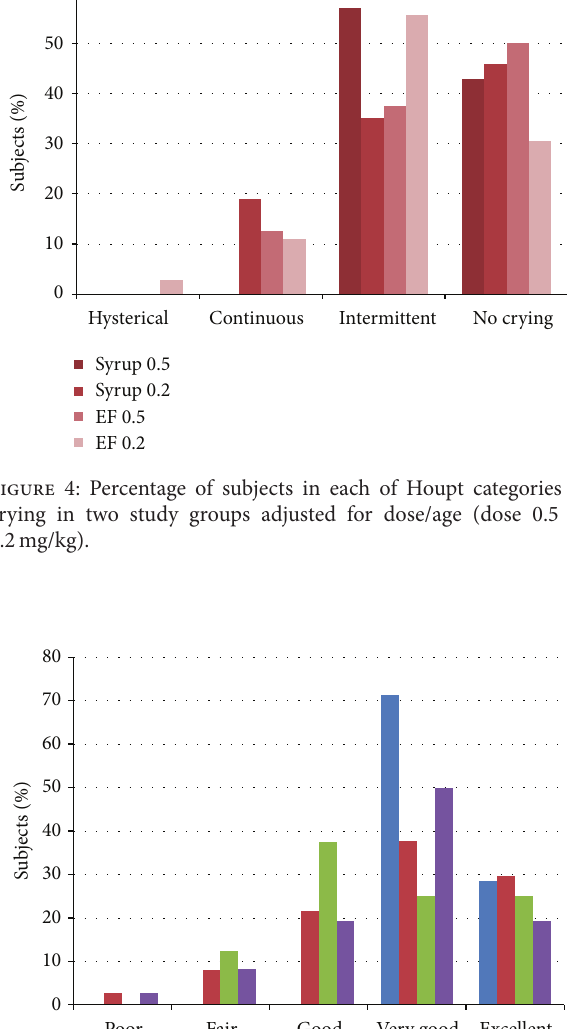
Figure 3: Percentage of children in each of Houpt categories of movement in two study groups adjusted for age (dose 0.5 or 0.2 mg/kg).